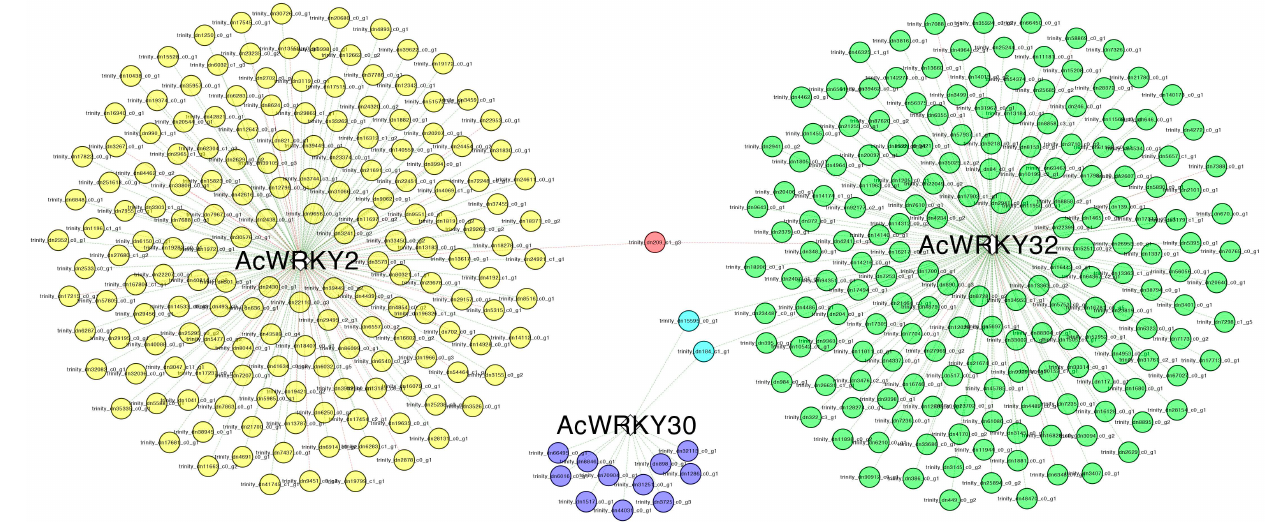
Figure 5. Co-expression network analysis of 3 AcWRKYs ( AcWRKY2, 30, 32 ) up-regulated during dormancy release (T 3 ) in the uninfected/OYDV infected bulb comparison. The network was obtained using the CoExpNetViz tool and visualized with Cytoscape. Green and red lines denote positive correlation and negative correlation, respectively. Details of genes involved in co-expression network analyses are provided in Table